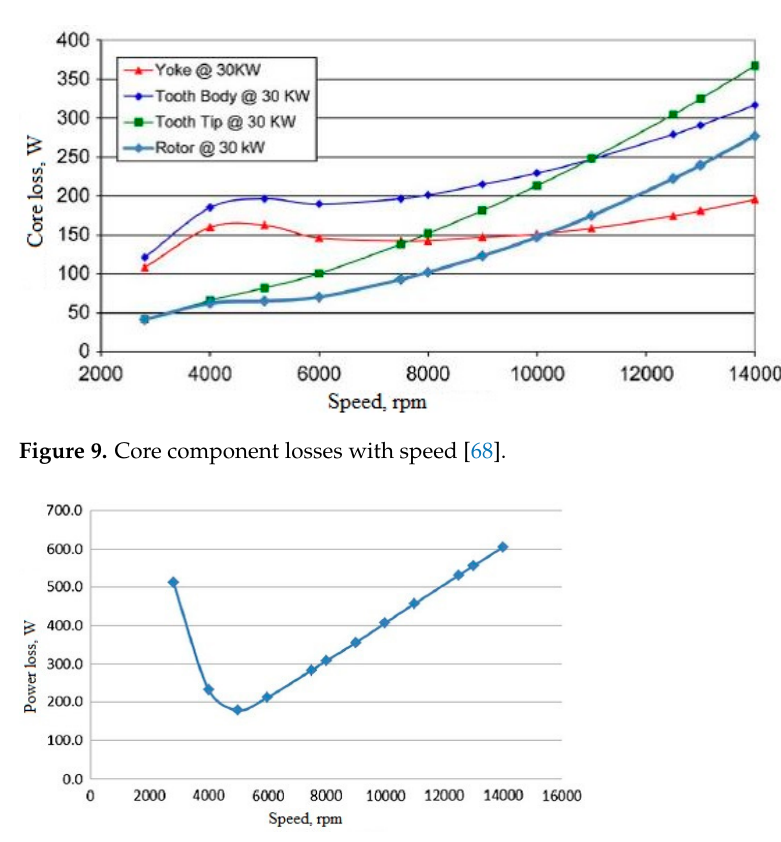
Figure 8. An overview of failures caused by uncontrolled temperature.